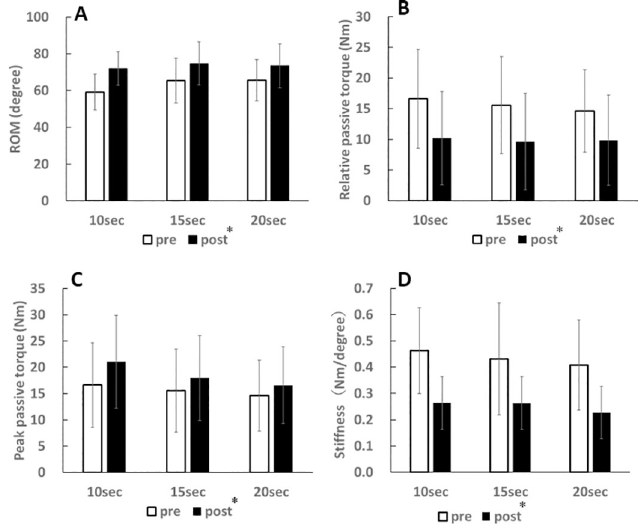
Fig 1. Effects of stretching on changes in ROM (A), relative passive torque (B), peak passive torque (C), and muscle-tendon unit stiffness (D). � p < 0.01 (pre vs. post).